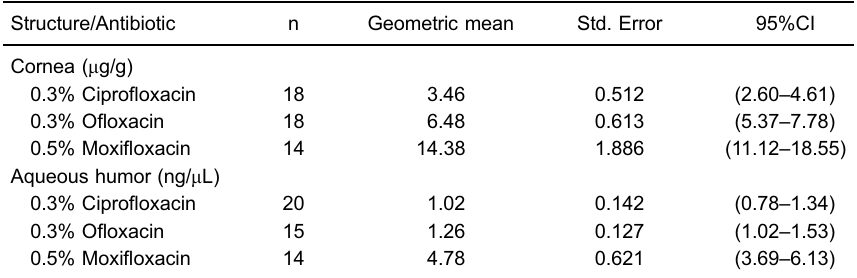
Table 2. Statistics summary of antibiotic concentrations in eyes immersed for ten minutes in three different solutions.